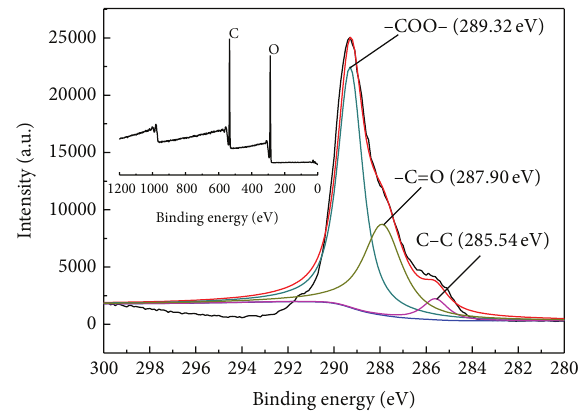
Figure 3: X-ray photoelectron spectroscopy of MWNTs-COOH.